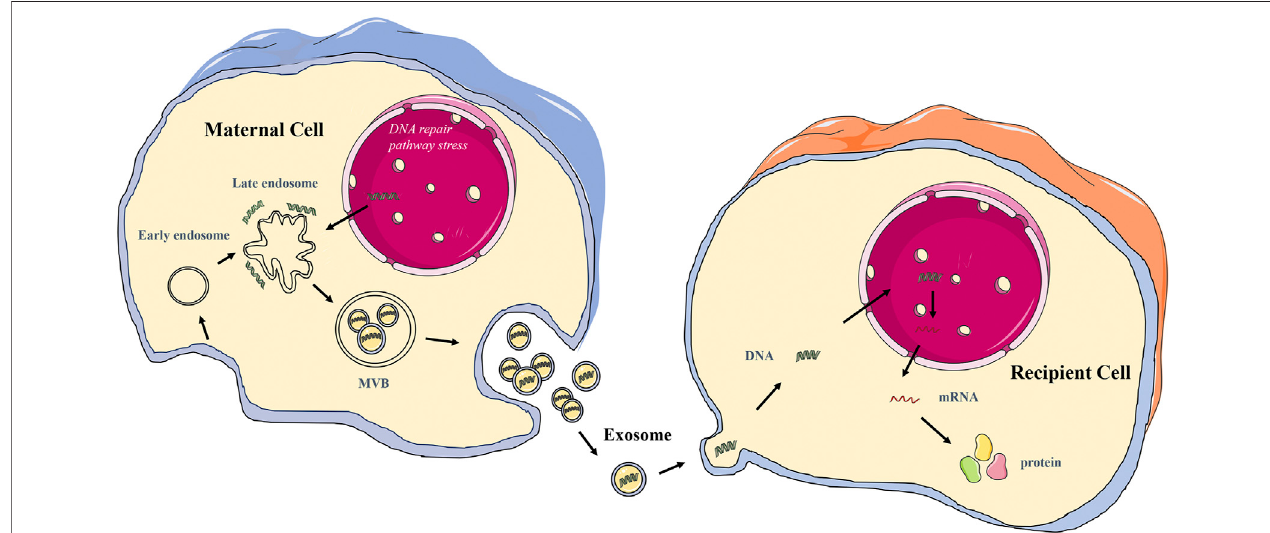
FIGURE 2 | The schematic diagram of exosome gDNA transfer between cells.